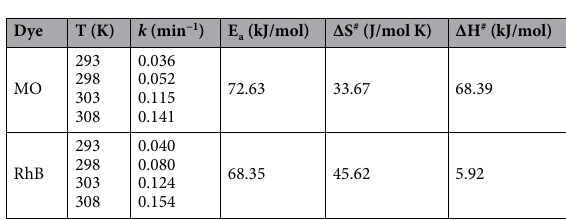
Figure 5. Time-dependent UV–visible spectra for the catalytic reduction of ( a ) MO and ( b ) RhB dyes by NaBH 4 in the presence of optimum amount of SGCN/Fe 3 O 4 /PVIs/Pd.